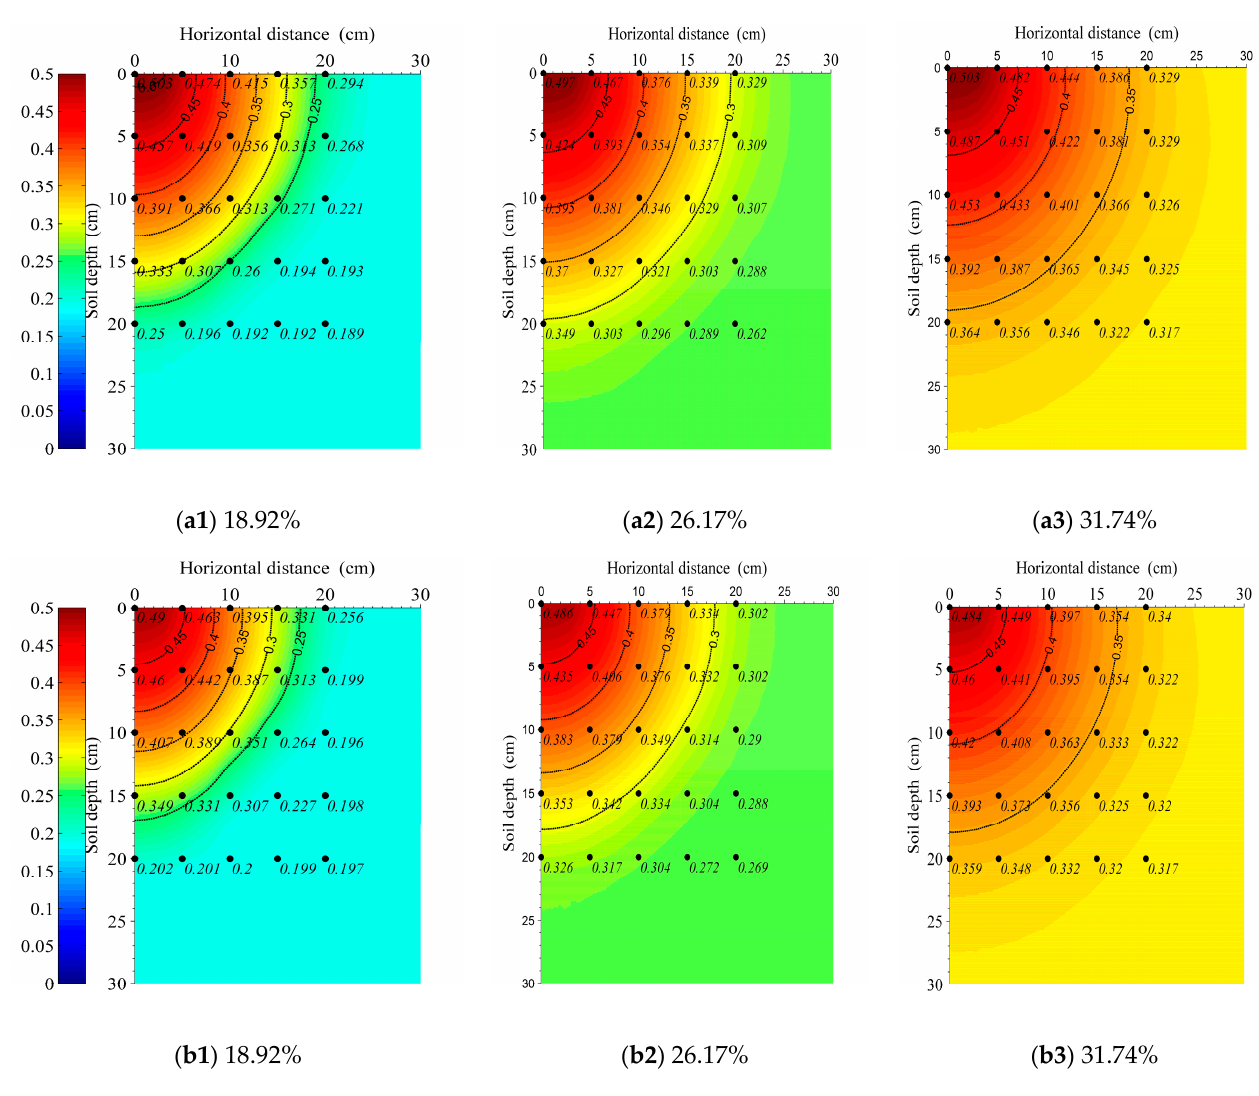
Figure 13. Comparison of final water distribution for three initial water content